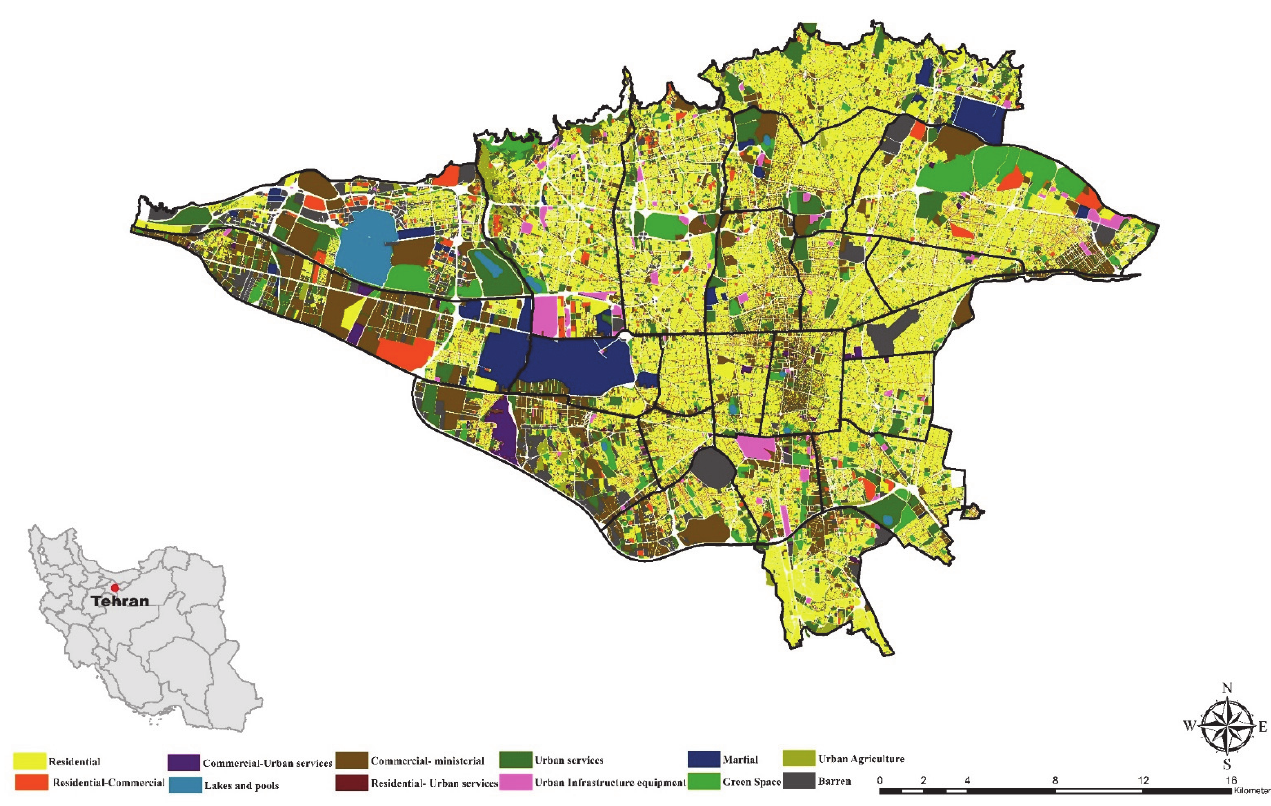
Figure 1. Study area, Tehran, and its land use classification.